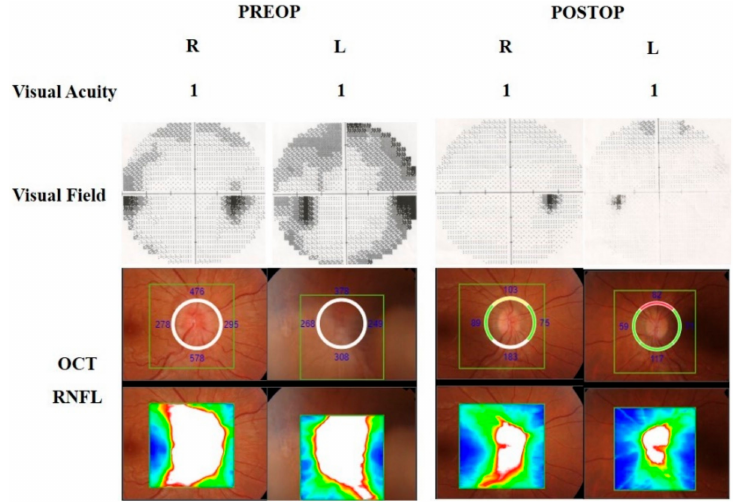
Figure 4. The 32-year-old pregnant patient (Case 7) was consulted with headaches and progressive visual impairment. The visual field showed bilateral enlargement of a blind spot with a general re- duction of sensitivity; peripheral nasal defects in the right eye and peripheral constriction apparently in the upper hemisphere in the left eye. Fundus examination revealed severe optic disc swelling. Retinal nerve fiber layer (RNFL) in optical coherence tomography (OCT) showed bilateral increased retinal nerve fiber thickness due to papilledema. Three months following endoscopic optic nerve decompression (EOND), bilateral RNFL thickness was decreased, and visual field defects improved.